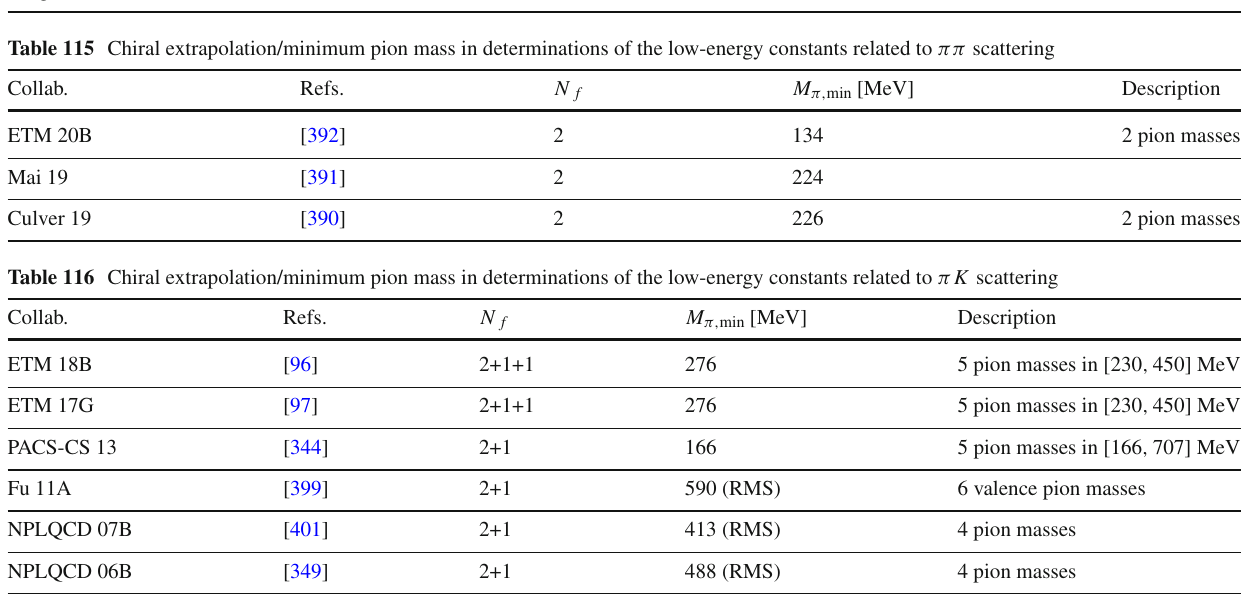
Table 117 Finite-volume effects in determinations of the SU ( 2 ) low-energy constants (cid:13), F , ¯ (cid:6) 4 , ¯ (cid:6) 6 , and SU ( 3 ) low-energy constants (cid:13) 0 , F 0 Collab. Refs.